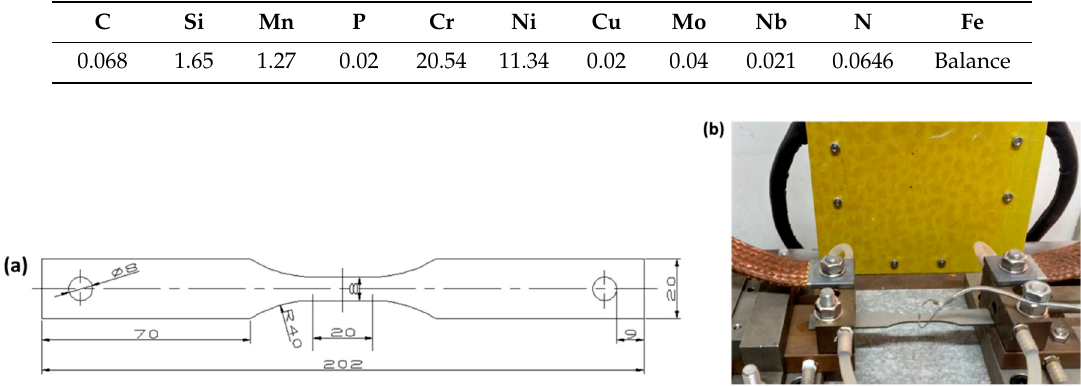
Figure 1. Geometry of thermal fatigue specimen (all units in mm) ( a ) and the test configuration ( b ).